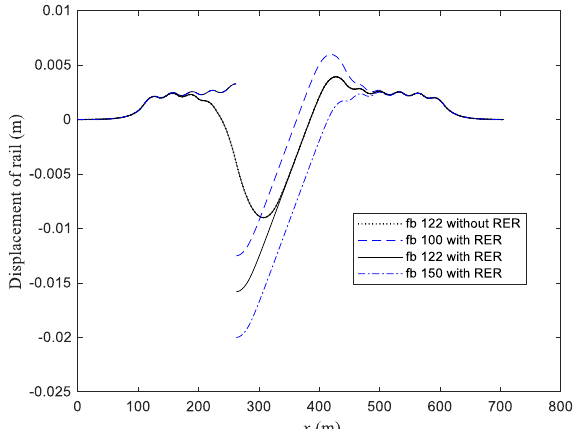
Figure 15. Longitudinal displacement of rail along its length, with the fixed bearing located at three different positions for the length of 180 m of continuous beam.